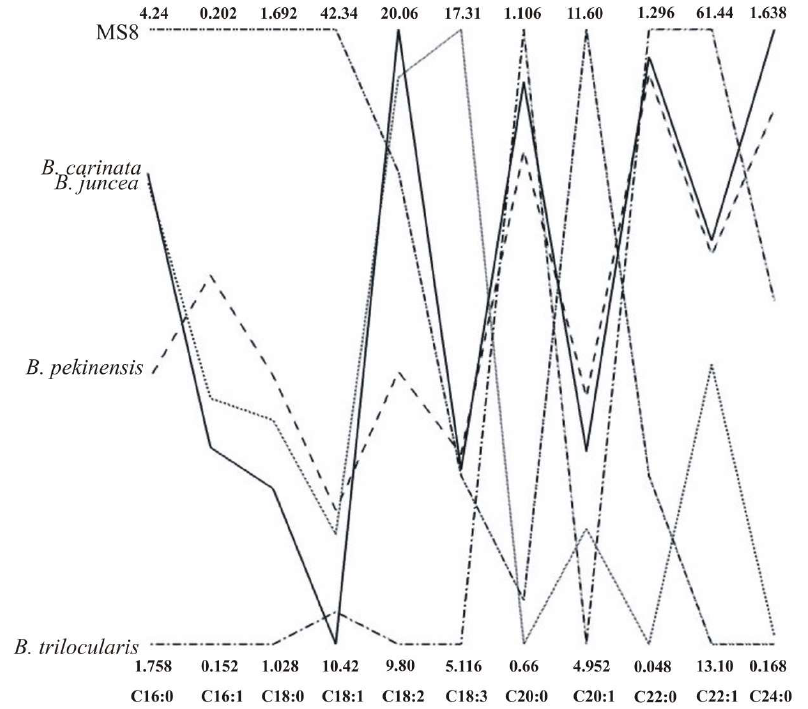
Figure 1. Parallel coordinate plots (PCPs) for five parental forms and 11 traits.